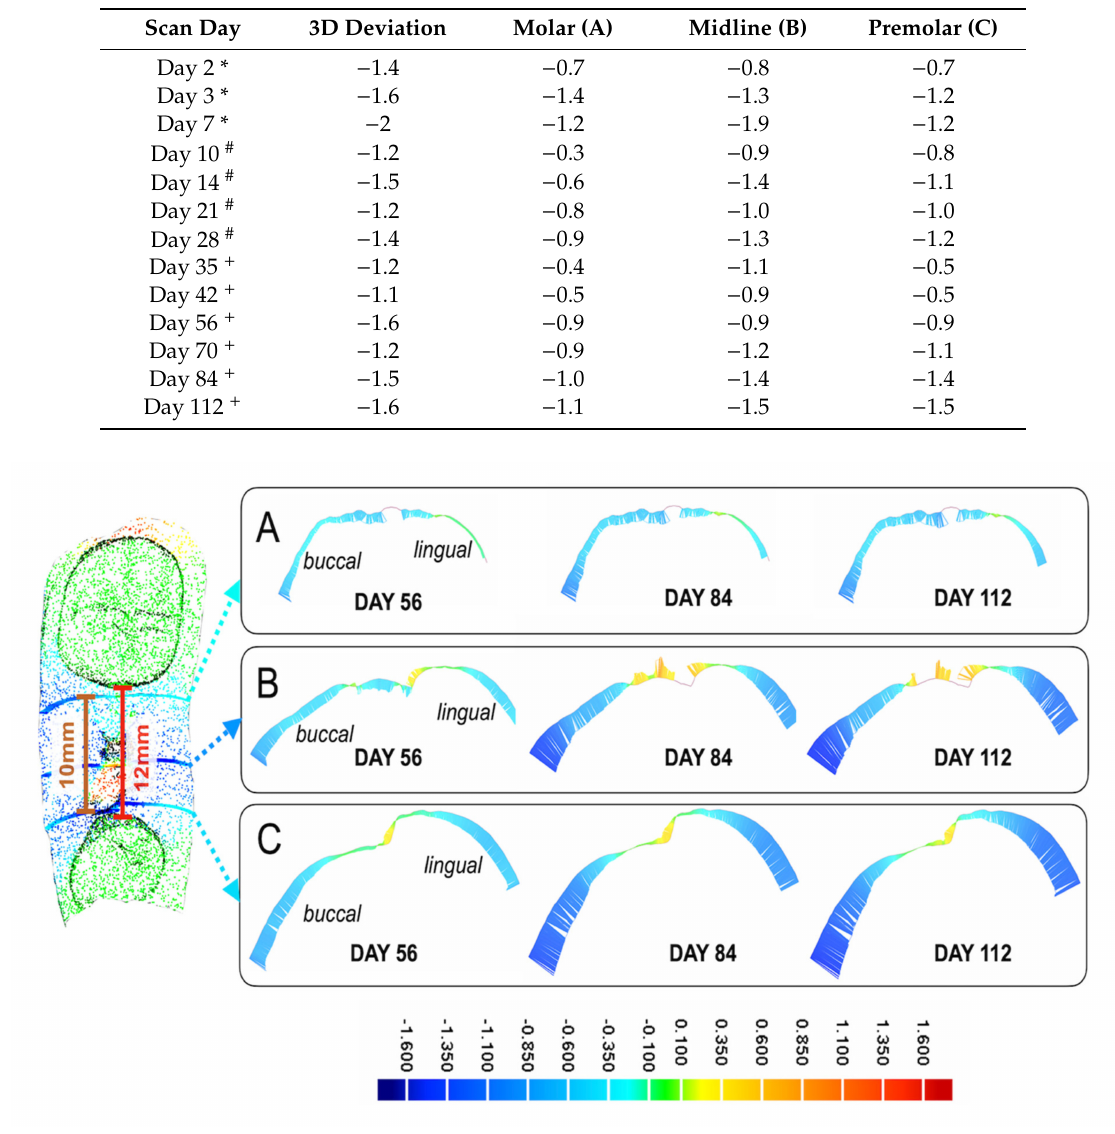
Figure 3. Residual alveolar ridge remodelling assessed through 2D comparison of sequential intraoral scans 112 days post-extraction of mandibular first molar versus the day 28 reference scan. The 2D analysis was performed using sagittal planes across the ridge at three locations: 1 mm from the second molar ( A ); midline of ridge ( B ); and 1 mm from second premolar ( C